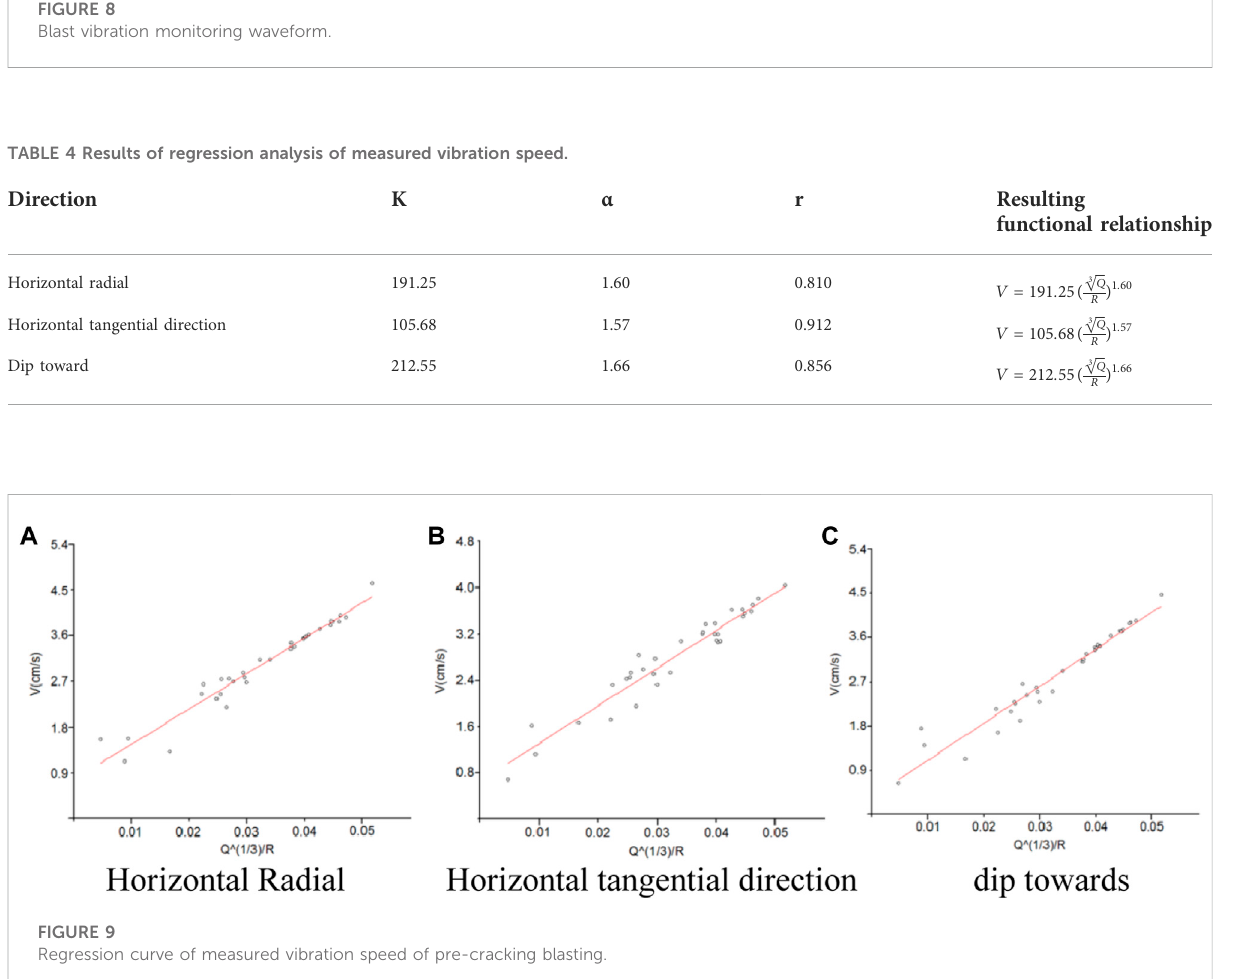
FIGURE 8 Blast vibration monitoring waveform.